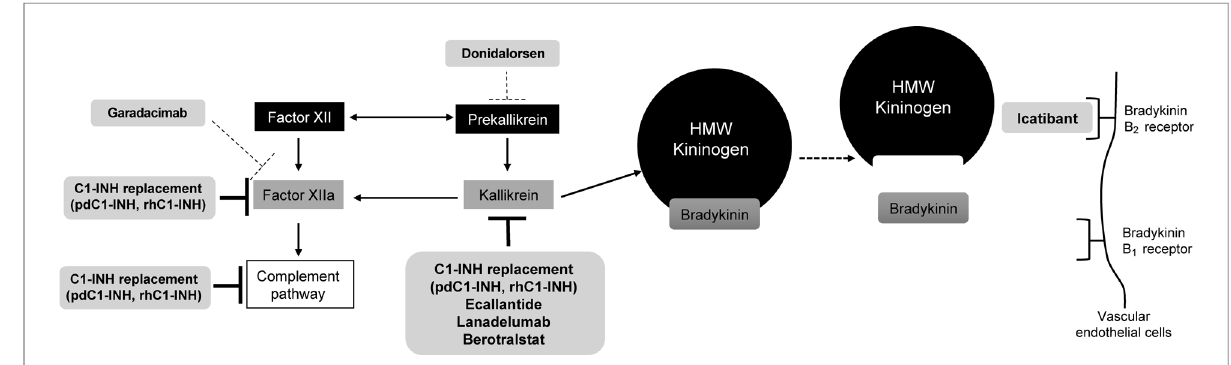
FIGURE 2 Therapeutic targeting of pathways in HAE. Inhibitors of the pathway are shown in light gray shaded boxes at their respective sites of action. Investigational therapies are shown with dashed lines at their target sites. C1-INH, C1 esterase inhibitor; HMW, high molecular weight; pdC1-INH, plasma-derived C1-INH; rhC1-INH, recombinant human C1-INH . Figure created with data from Cicardi M, et al. J Allergy Clin Immunol Pract. (2018) 6(4):1132 – 41; Zuraw BL. N Engl J Med. (2008) 359(10):1027 – 36; and Fijen LM, et al. Clin Rev Allergy Immunol. (2021) 61(1):66 – 7 (5, 14,